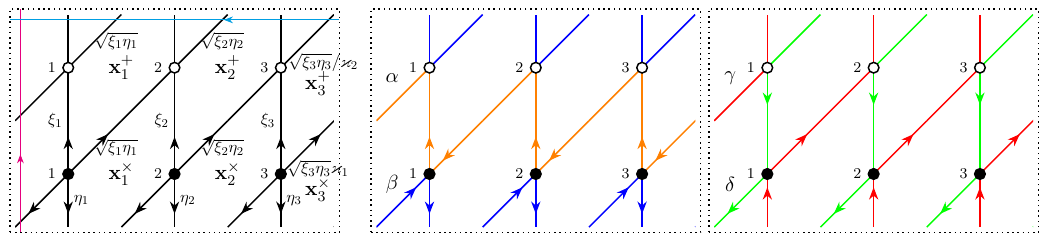
Figure 3 . Left: bipartite graph for the Toda chain. Center, right: zig-zag paths (cid:11); (cid:12); (cid:13); (cid:14)